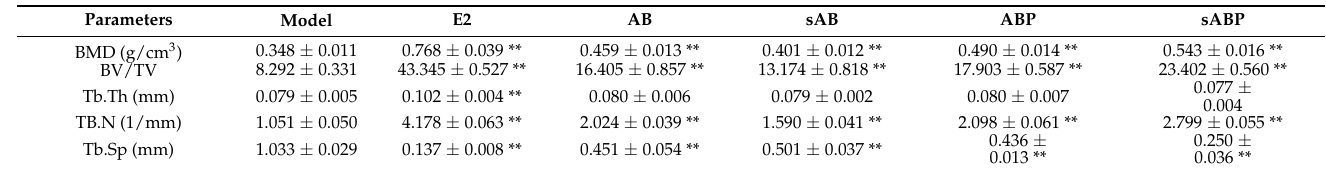
Table 2. µ CT 3-D parameters of trabecula bone in the distal femur